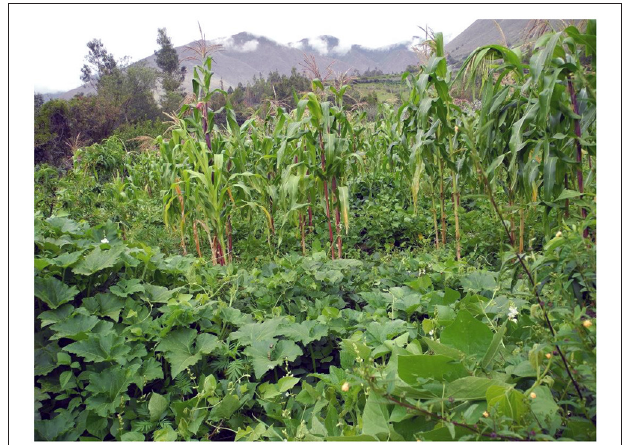
FIGURE 8 | Multi-species maize field (maizal) functioning as “key agrobiodiversity-and-food space” in fieldwork visit (February 2017). Photo credit: Karl